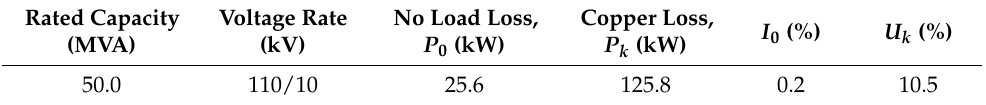
Table 1. Parameters of the HV/MV